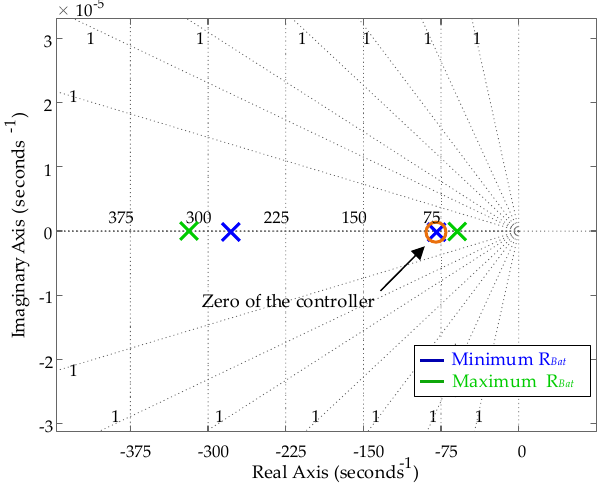
Figure 11. Closed-loop pole, zero for di ff erent values of the battery internal resistance R bat .